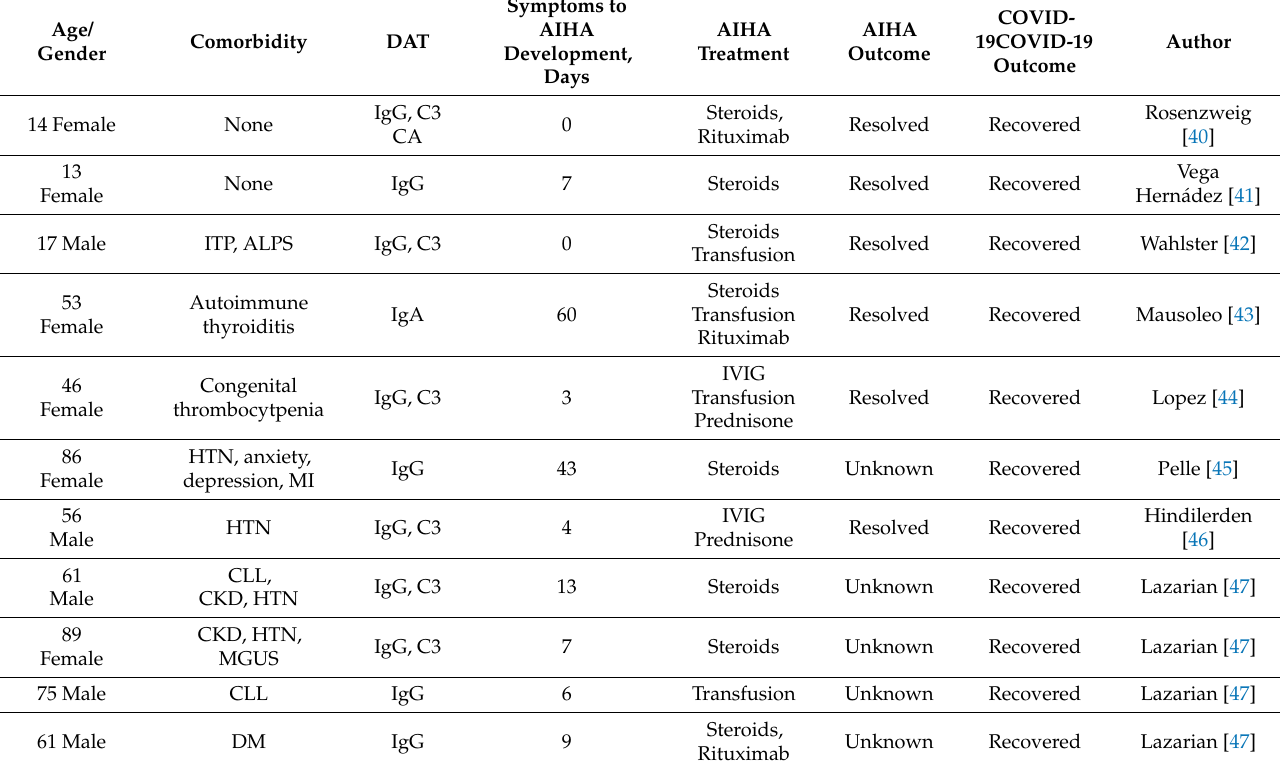
Table 1. WAIHA associated with SARS-CoV-2